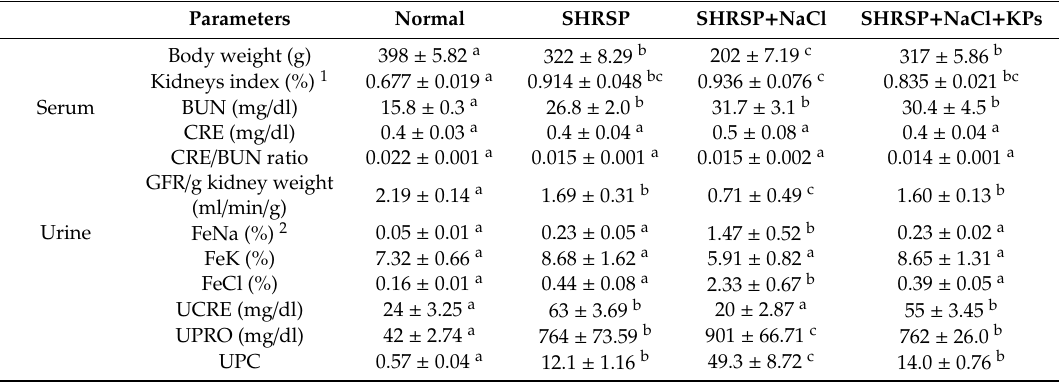
Table 1. E ff ects of kefir peptides (KPs) on the body weight, organ index, BUN, CRE, CRE / BUN ratio, urine fractional excretion of electrolytes (FeX), UCRE, UPRO, and UPC in di ff erent treatment groups of SHRSP